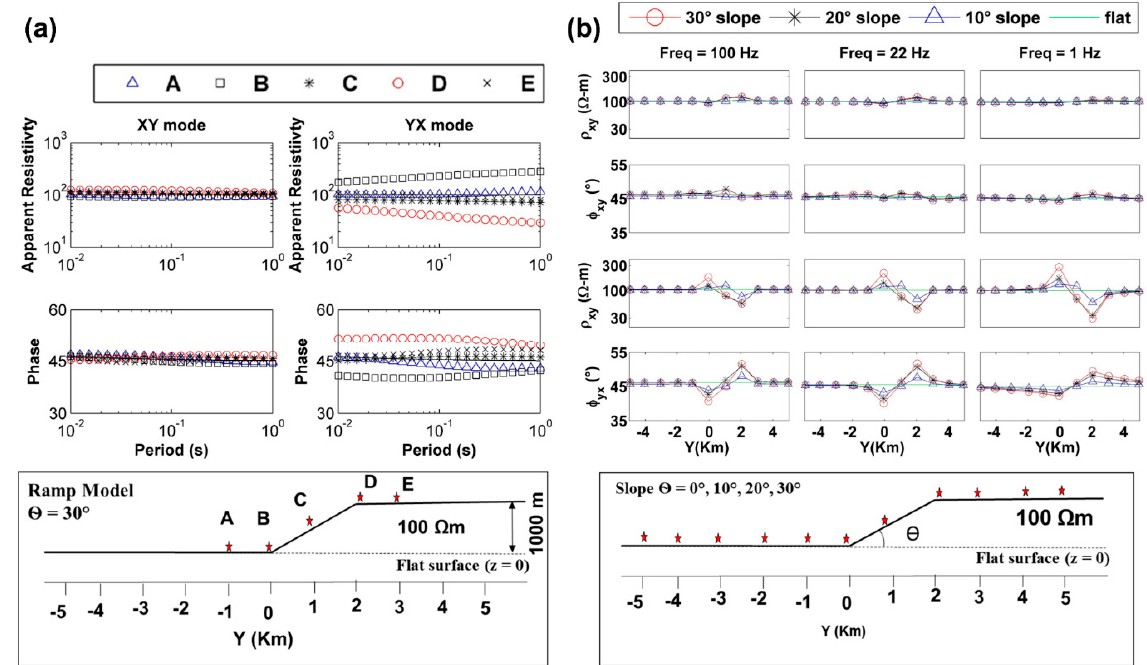
Figure 4. ( a ) The comparison of off-diagonal components of apparent resistivity and phase at five sites (A, B, C, D and E). These sites are located on the ramp of 30 ◦ slope. ( b ) The MT responses of 11 sites on the ramp model of different slope’s angle were compared at frequency 100 Hz, 22 Hz and 1 Hz.